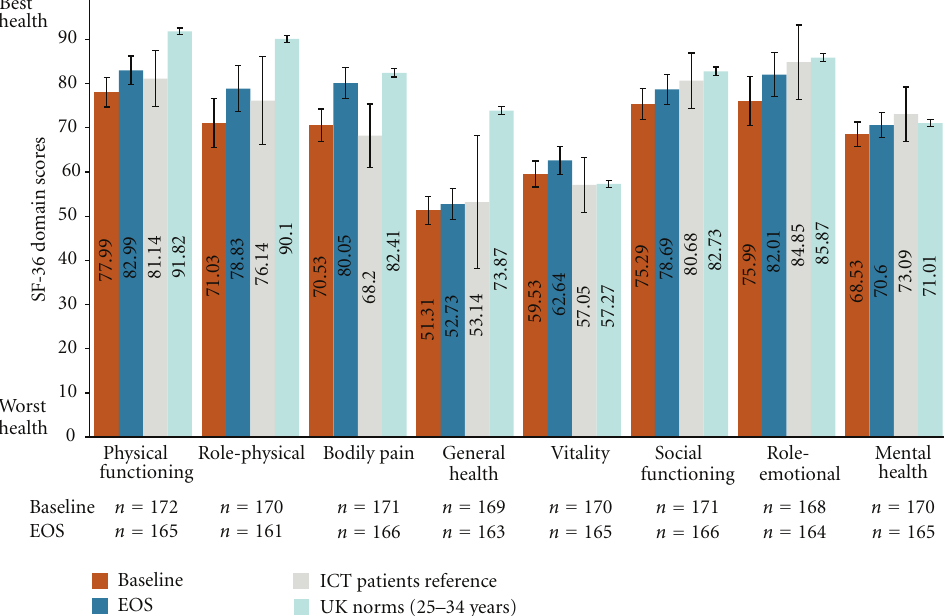
Figure 1: Mean SF-36 domain scores for β -thalassemia population versus disease-related and general population references at baseline and EOS. Data illustrated in the above figure are representative of the mean and 95% confidence interval estimates of the mean as calculated ÷√ n . Reference data for ICT patients were based on Payne et al. [3] (where 82% of patients using the formula: 1.96 ∗ standard deviation